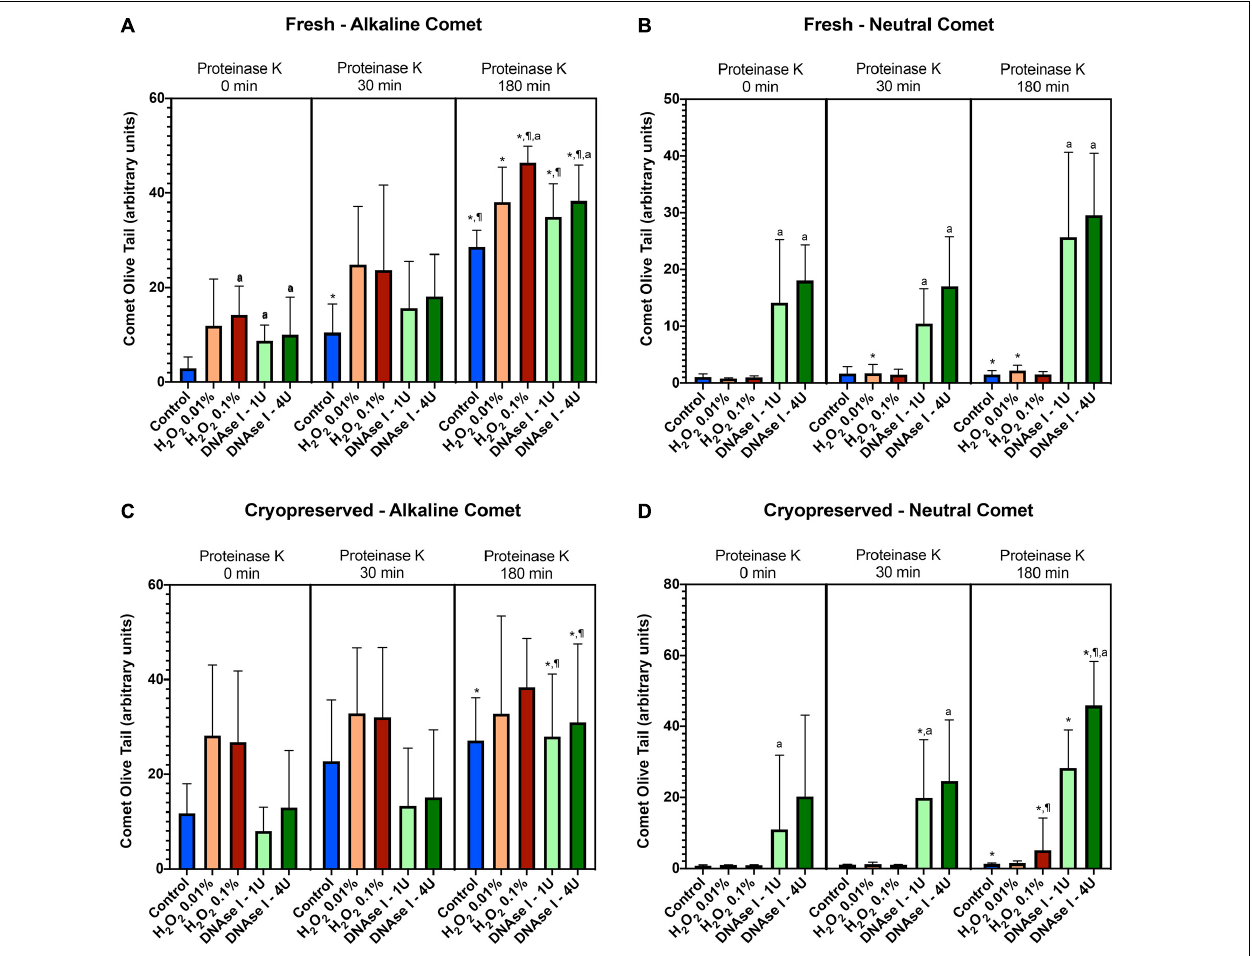
FIGURE 3 | Comet olive tail moment (OTM) showing the amount of DNA breaks detected in sperm after different proteinase K treatments. Panel (A) shows OTM for alkaline Comet in fresh samples. Panel (B) depicts OTM for neutral Comet in fresh samples. Panel (C) shows OTM for alkaline Comet in cryopreserved samples. Panel (D) depicts OTM for neutral Comet in cryopreserved samples. (*) Statistical differences compared to the similar treatment in 0 min of proteinase K ( P < 0.05). (¶) Statistical differences compared to the similar treatment in 30 min of proteinase K ( P < 0.05). (a) Statistical differences compared to the control of the same proteinase K treatment ( P < 0.05). TABLE 2 | Area under the curve for the determination of sperm cells with fragmented DNA in each proteinase K condition. Lysis containing proteinase